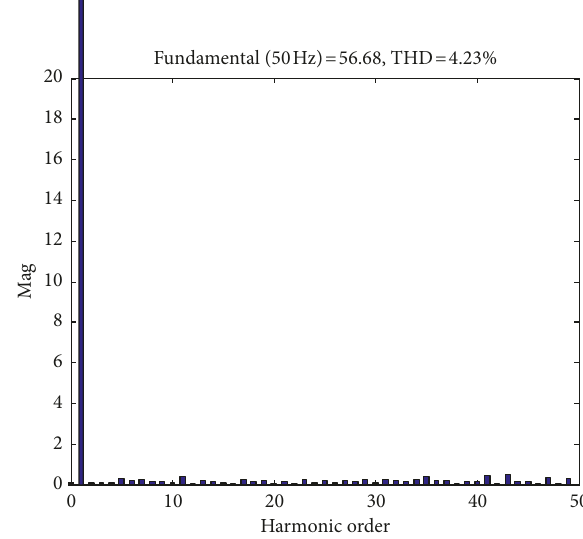
Figure 18: FFT analysis of nonlinear load current using PI con- troller and multi-VR controllers.